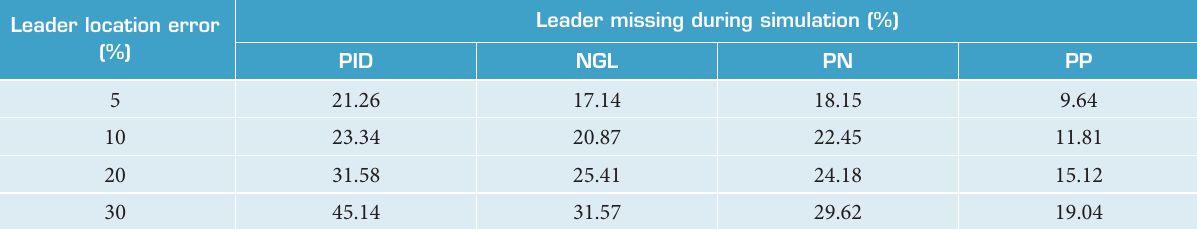
Table 3. Leader missing due to leader location